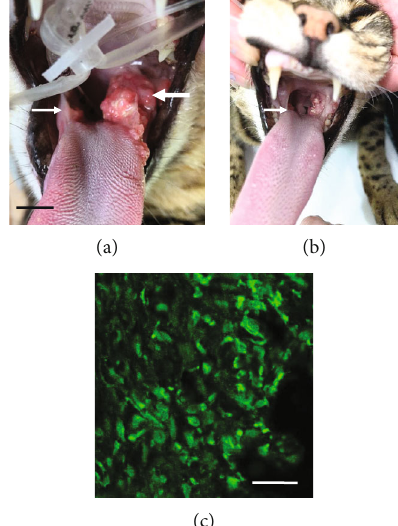
Figure 13: The photographs in (a) depicts the appearance of a large tumor located in the left oral pharynx (large arrow) and a second, smaller mass on the right (small arrow) that was discovered on initial physical examination (a). The photograph in (b) depicts the tumors midway through a third treatment with TOL. Note that the smaller tumor is no longer apparent (small arrow) and the larger tumor is signi fi cantly reduced. The calibration bar in (a) is 3 mm. The photomicrograph in (c) depicts the immunohisto fl uorescent labeling of VGSCs observed in a tissue sample taken from the tumor in (a) before treatment with TOL. Note that TOL was the only treatment provided in the management of the tumors. The calibration bar in (c) is 25 μ